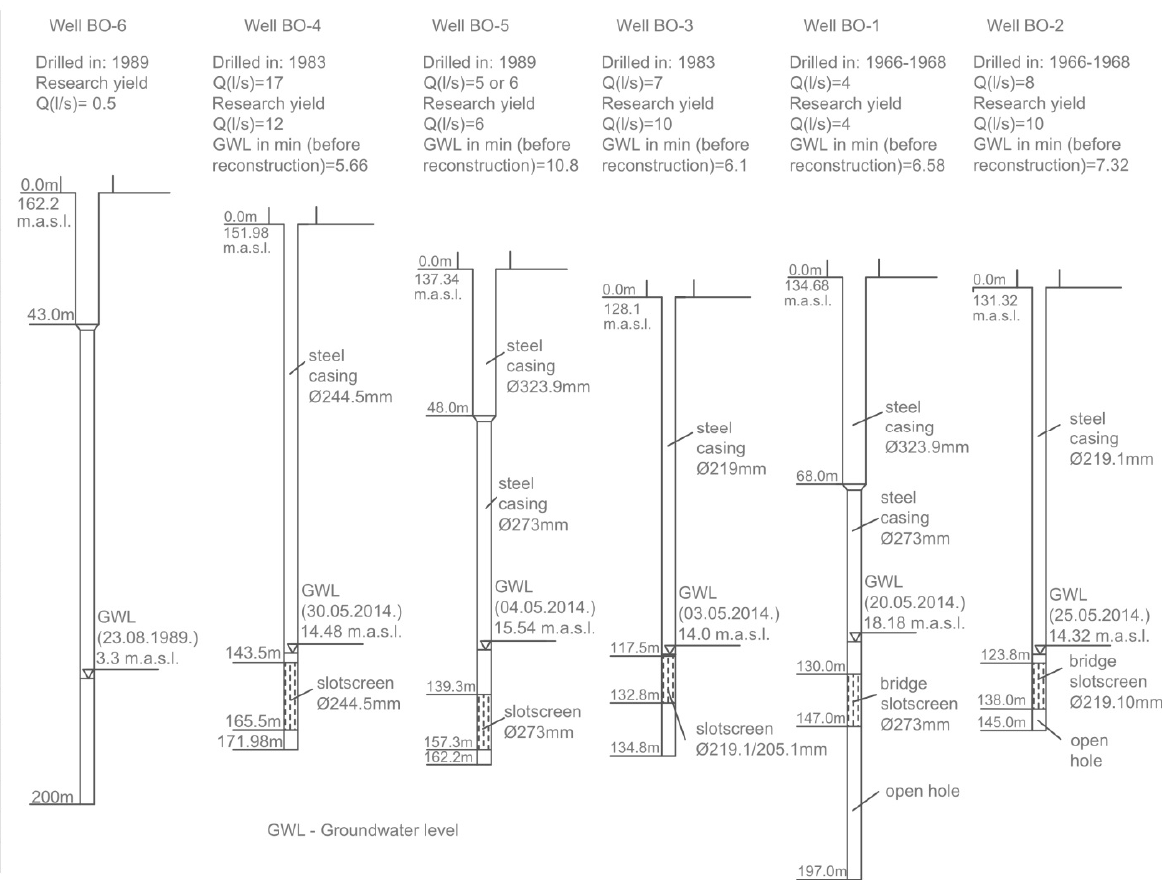
Figure 3. Profiles of the Korita wells based on a reconstruction using available data for basic parameters.